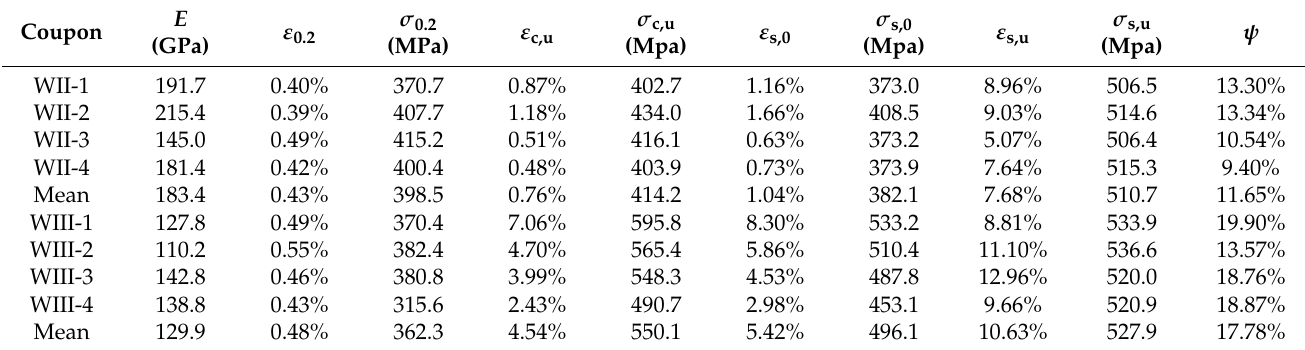
Table 9. Crucial tensile mechanical properties of type II and type III TC bimetallic steel welded joints.